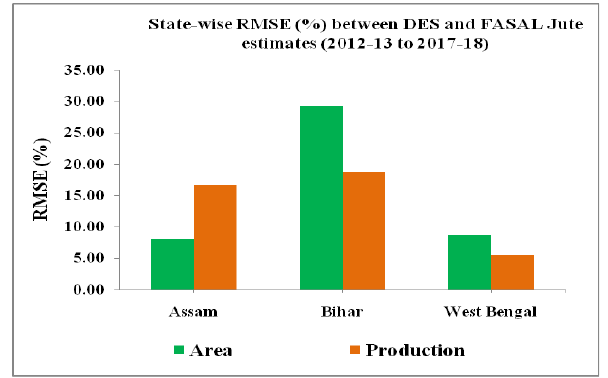
Figure14.State wise DES and FASAL estimates, comparison